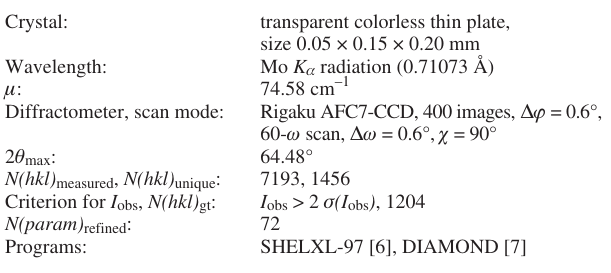
Table 1. Data collection and